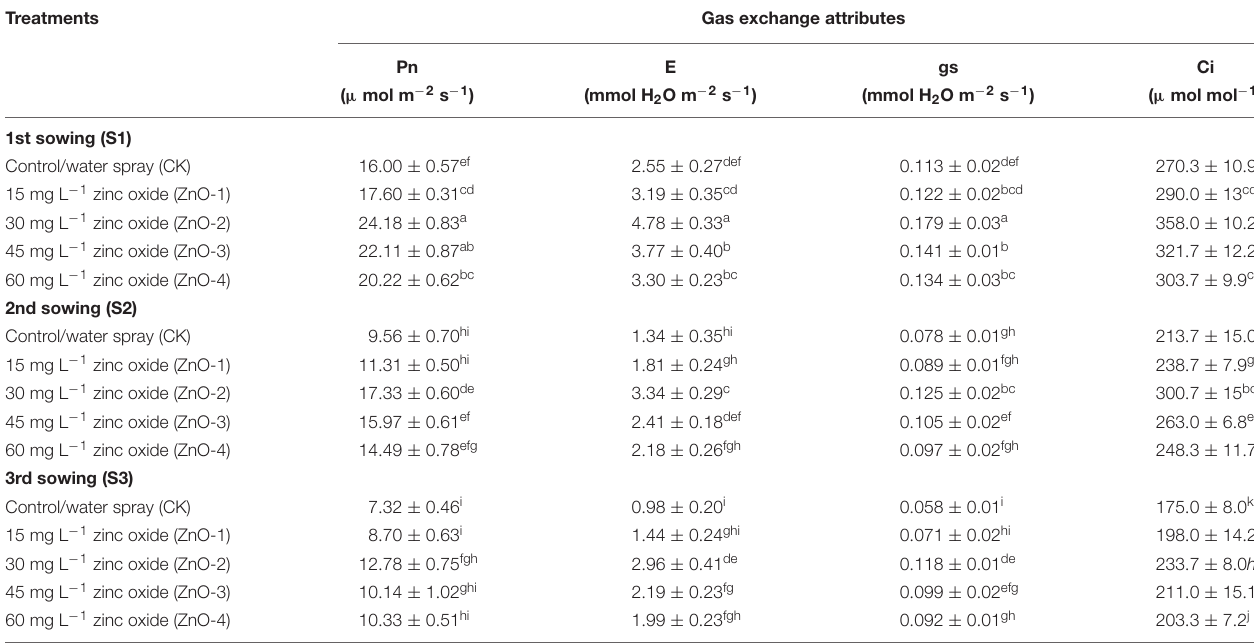
TABLE 1 | Effect of foliar application of zinc oxide nanoparticles (nano-ZnO) on gas exchange determinations: photosynthetic rate (Pn), transpiration (E), stomatal conductance (gs), and intracellular CO 2 concentration (Ci) in Vigna radiata (L.) under sowing time generated heat stress. Treatments